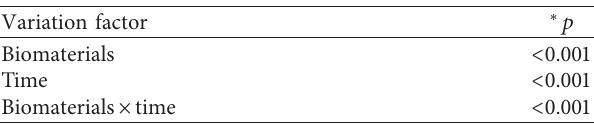
Figure 3: Photomicrograph of histological sections: (A) histo- logical detailed features of the biomaterials (BIO, BFL, CLN, and LBP) and surrounding tissues in the central region of the defect at 40 days (HE, original magnification 40x); (B) mallory trichrome staining (original magnification 40x). CT: connective tissue; NB: newly bone formed; OLC: osteoblastic line cells. In CLN: (a) Mallory trichrome staining, (b) HE, original magnification 40x. Table 1: Statistical difference between source of variation time and group (two-way ANOVA